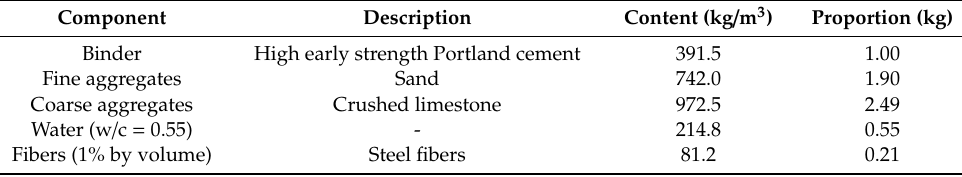
Table 4. Parameters of the concrete mixtures utilized in this study.